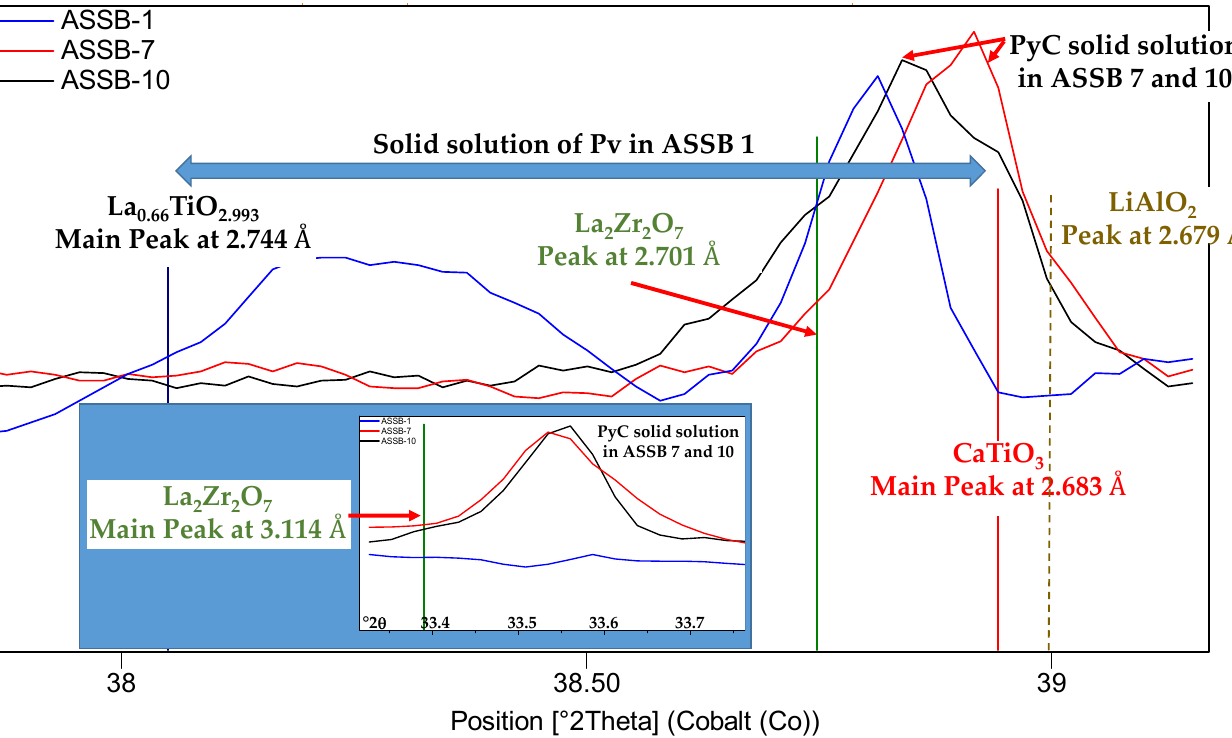
Figure 8. Section of PXRD measurements with the main peaks of Ca/La oxysilicate, britholite, CaZrO 3 , and ZrO 2 (from left to right).